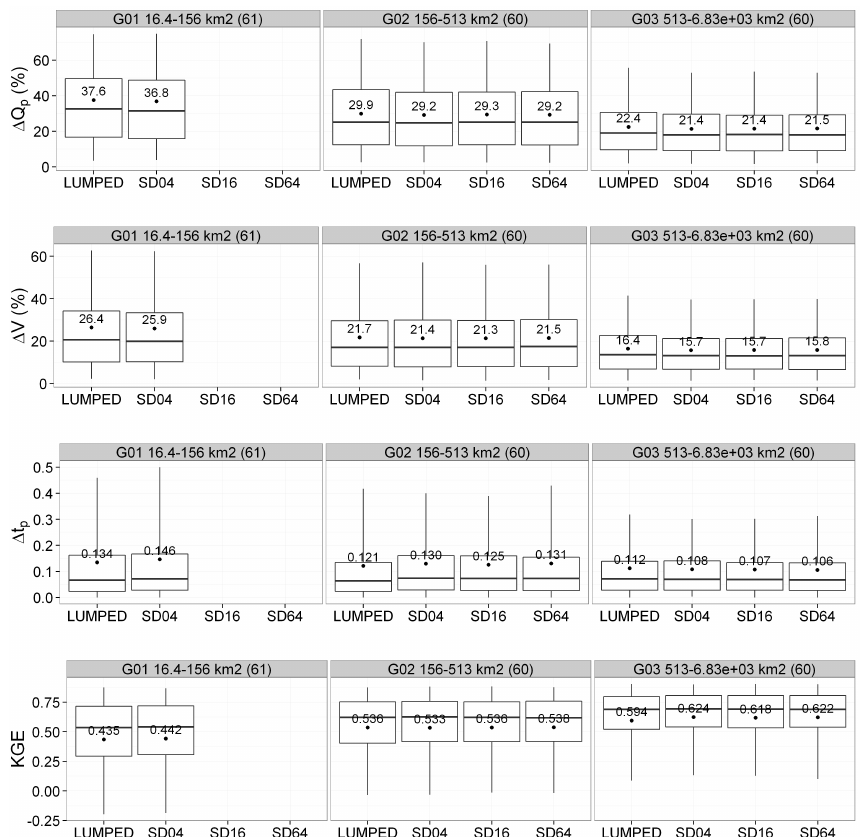
Fig. 9. Distributions of model performance in validation mode using the four efficiency criteria (top to bottom panels) for three catchment groups (G01, G02, and G03, left to right panels) sorted by increasing catchment area. Model performance was computed for 3620 flood events and for different spatial resolutions of precipitation forcing (LUMPED, SD64, SD16 and SD04). The box plots show the 5th, 25th, 50th, 75th, and 95th percentiles, and the mean value is given and shown by a dot.